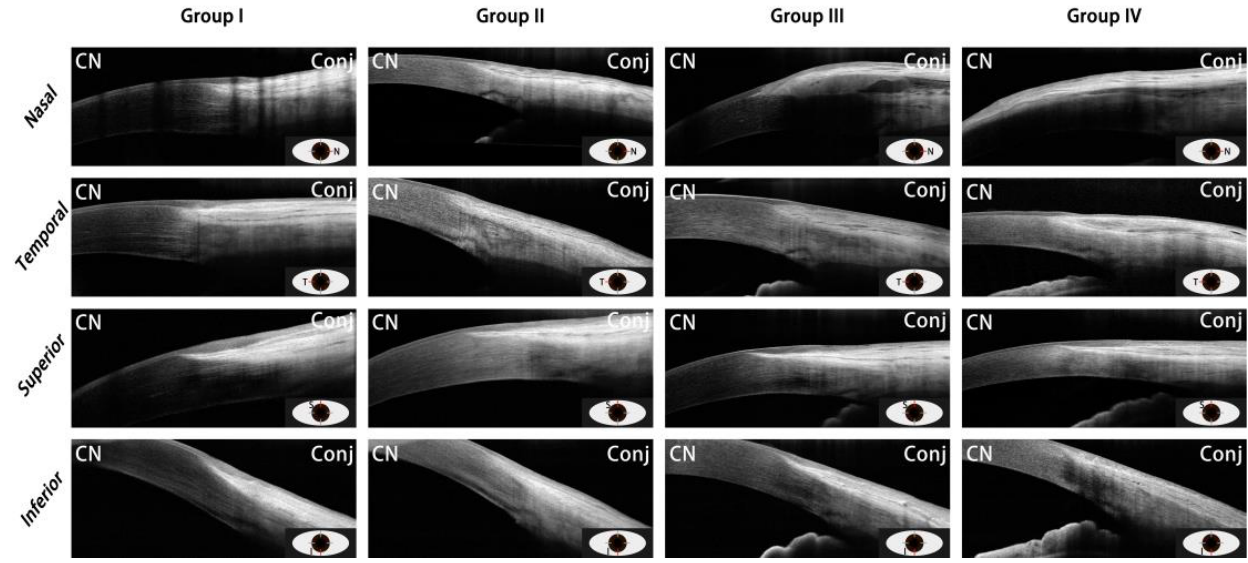
Figure 2. Representative OCT images of each quadrant of each of the four groups are shown. All images were of the right eye of subjects. The images of the following participants are shown: Group I, 22-year-old male healthy subject; Group II, 65-year-old female healthy subject; Group III, 36-year-old male pterygium patient; Group IV, 65-year-old male pterygium patient. CN, cornea; Conj, conjunctiva; OCT, optical coherence tomography. Table 2. Palisades of Vogt epithelial thickness (POV-ET)/Bowman’s membrane epithelial thickness (BM-ET) ratios of groups in each